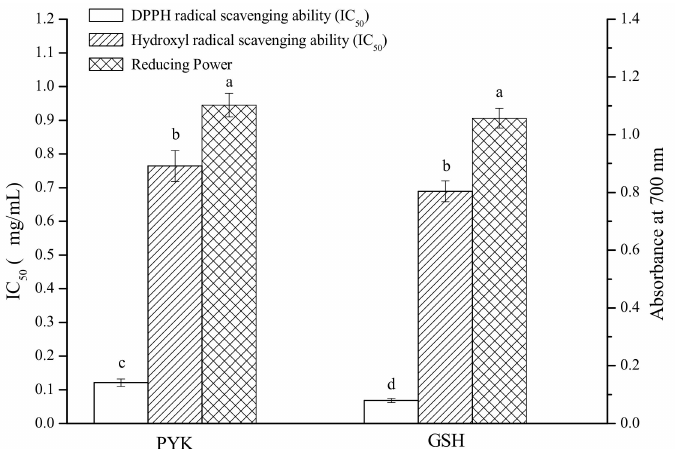
Figure 4. Radical scavenging ability (IC 50 ) and reducing power (samples at 0.5 mg / mL) of Pro-Tyr-Lys (PYK) and L-glutathione GSH. The columns having the same letter are not significantly di ff erent ( p >